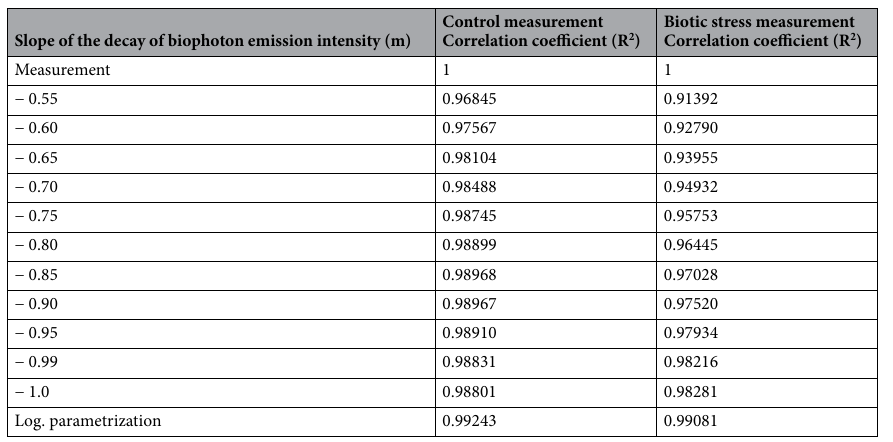
Table 3. Correlation coefficients (R 2 ) between measured and estimated biophoton emission intensities (count/ min) on Leaf A in the Control and Biotic-stressed groups using different slope parameters.